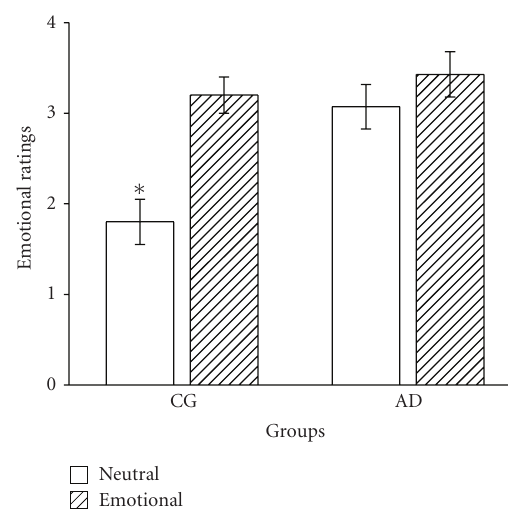
Figure 1: Ratings (mean ± SEM) of emotionality for neutral and emotional stories by the two groups: CG, control group, and AD, Alzheimer’s patients. The subjects were asked to rate their emotional reaction to the slide show immediately after its presentation on a scale of 0 (not emotional) to 4 (highly emotional). ∗ P < . 005 was compared to AD for Neutral version (independent samples t- test). The scores assigned to the Emotional version were not di ff erent between the groups ( P = .